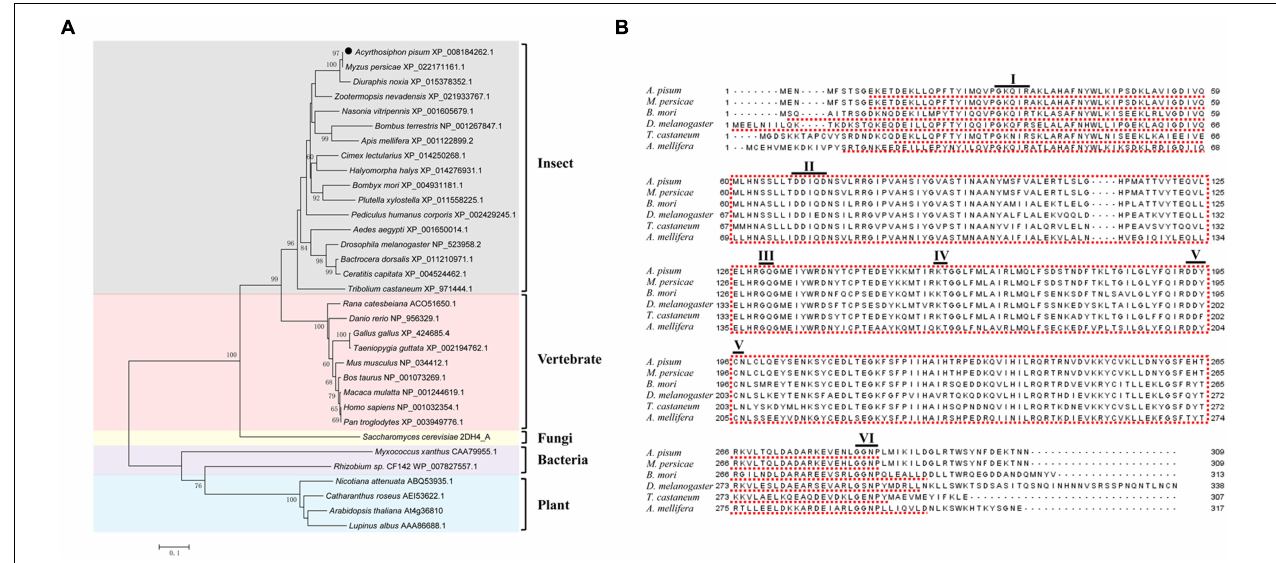
FIGURE 1 | Phylogenetic tree and sequence alignments of GGPPS. (A) Phylogenetic tree of GGPPS generated by MEGA 5.05. (B) Alignment of the amino acid sequence of Acyrthosiphon pisum GGPPS with other insect GGPPS. A. pisum , Acyrthosiphon pisum ; M. persicae , Myzus persicae ; B. mori , Bombyx mori ; D. melanogaster , Drosophila melanogaster ; T. castaneum , Tribolium castaneum ; A. mellifera , Apis mellifera . Conserved motifs are underlined, and the first and second aspartate-rich motifs (FARM: motif II and SARM: motif V, respectively) are DDIQD and DDYCN.